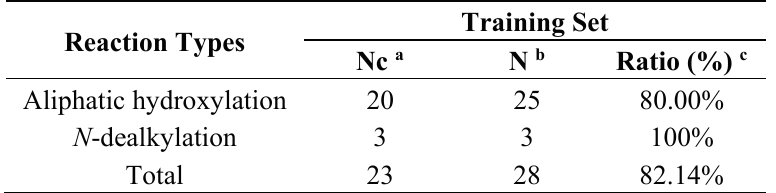
Table 2. Prediction accuracy for the training set using the top three sites for the mechanism-based prediction